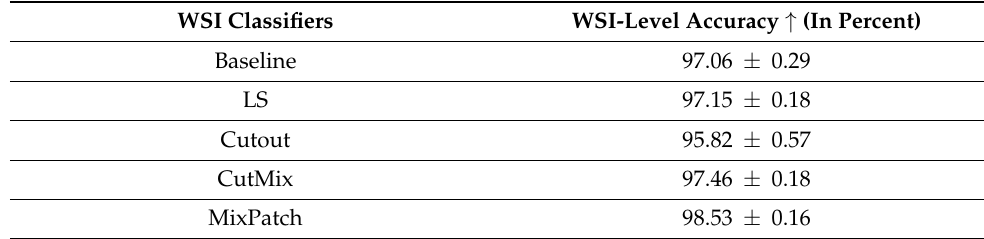
Table 8. Performance in WSI